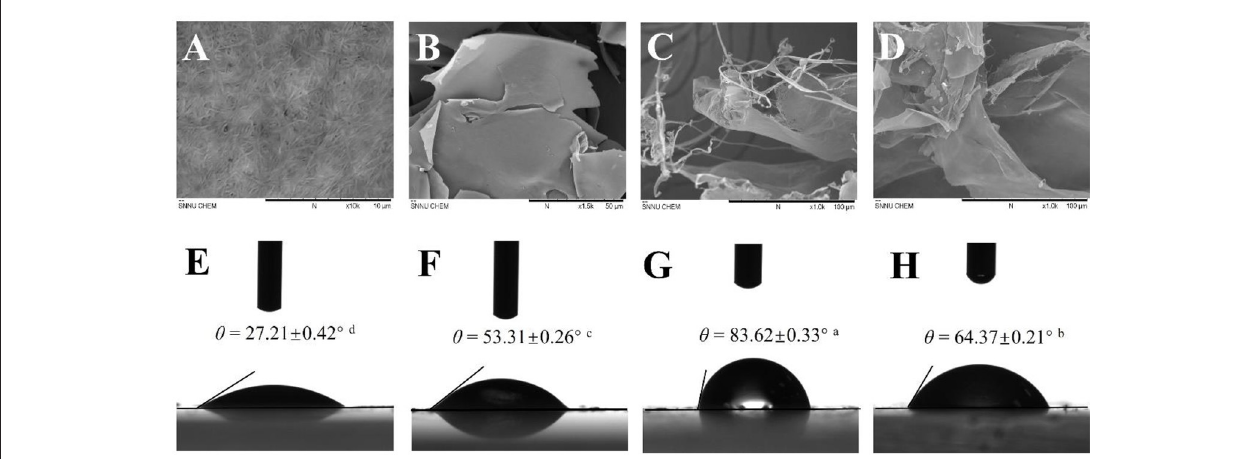
FIGURE 1 | Scanning electron microscopy (SEM) images of bacterial cellulose nanofibers (BCNs) ( A , at 10.0K magnification), soy protein isolate (SPI) ( B , at 1.5K magnification), A-BCNs/SPI colloidal particles ( C , at 1.0K magnification), and S-BCNs/SPI colloidal particles ( D , at 1.0K magnification). Water contact angle values of BCNs (E) , SPI (F) , A-BCNs/SPI colloidal particles (G) , and S-BCNs/SPI colloidal particles (H)